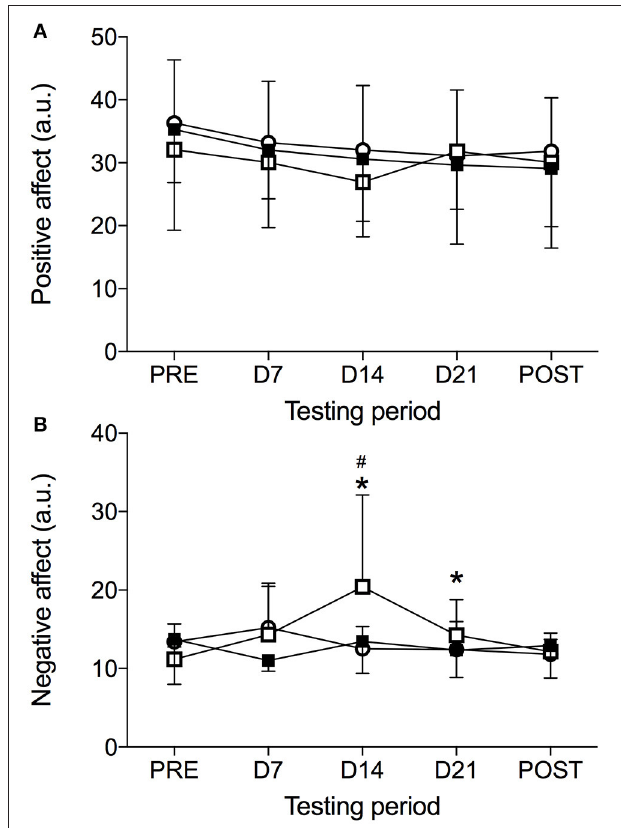
FIGURE 1 | The Positive Affect and Negative Affect Schedule values [PANAS, Positive Affect (A) and Negative Affect (B) ] obtained before (PRE), on days 7 (D7), 14 (D14), 21 (D21), and immediately after (POST) hypoxic ambulatory condition (HAMB, open circles), hypoxic bed rest condition (HBR, open squares) and normoxic bed rest (NBR, full squares) condition. *Denotes significant difference within the HBR condition compared to PRE ( p < 0.05); # Denotes significant difference within the HBR condition compared to POST ( p <